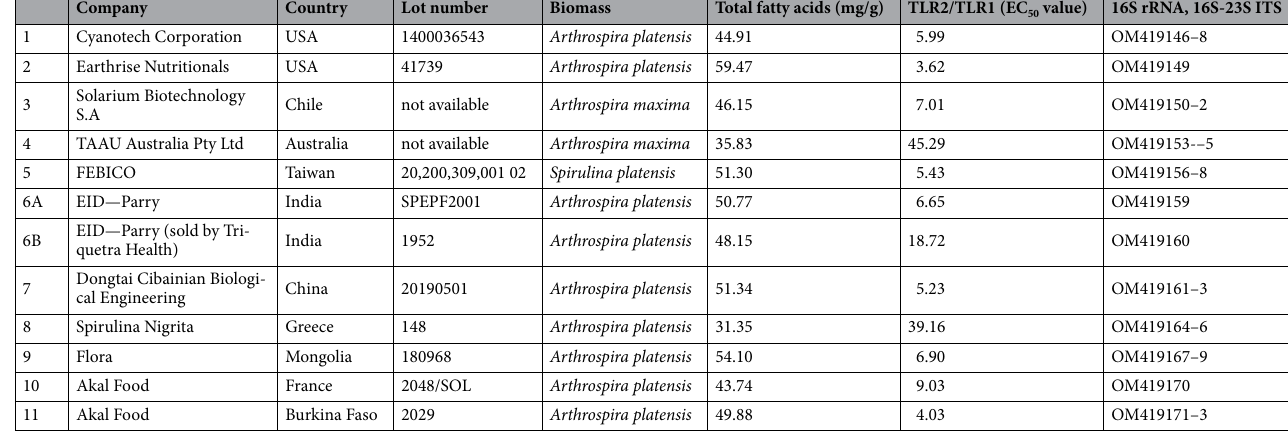
Table 1. Variation in total fatty acid content and immune-enhancing activity (TLR2/TLR1 activation) in biomass samples obtained from various commercial growers throughout the world. Biomass identification is based on the company literature, 16S rRNA and 16S-23S ITS region sequences were obtained in this study. EC 50 values represent the concentration (µg/mL) of biomass material required to induce activation for the TLR2/TLR1 signaling pathway to levels 50% of those achieved by Pam 3 CSK 4 (100